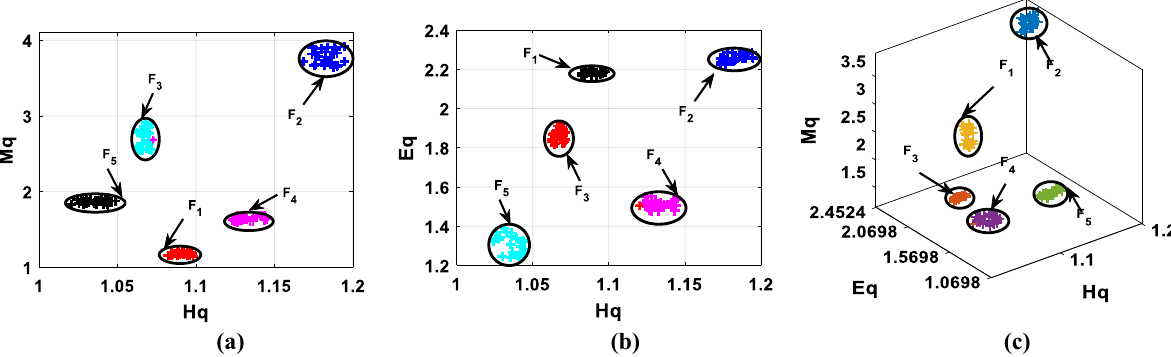
Fig. 19 M- MFDFA scatter plots for different faults in terms of KI data a scatter plot between Hq and Mq, b scatter plot between Hq and Eq, c 3-D scatter plot among Hq, Eq, and Mq